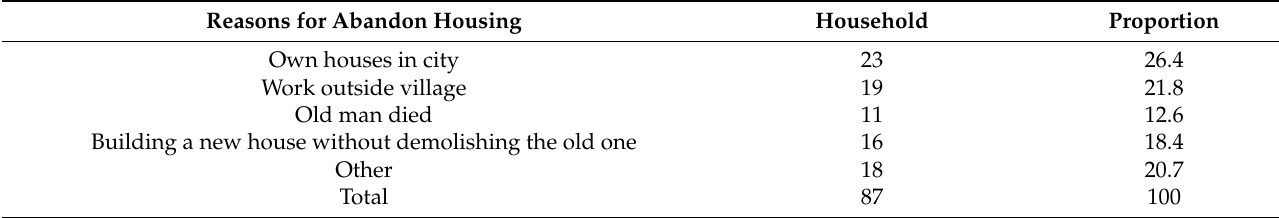
Table 3. Questionnaire results for the reasons why villagers abandoned their old houses. Reasons for Abandon Housing